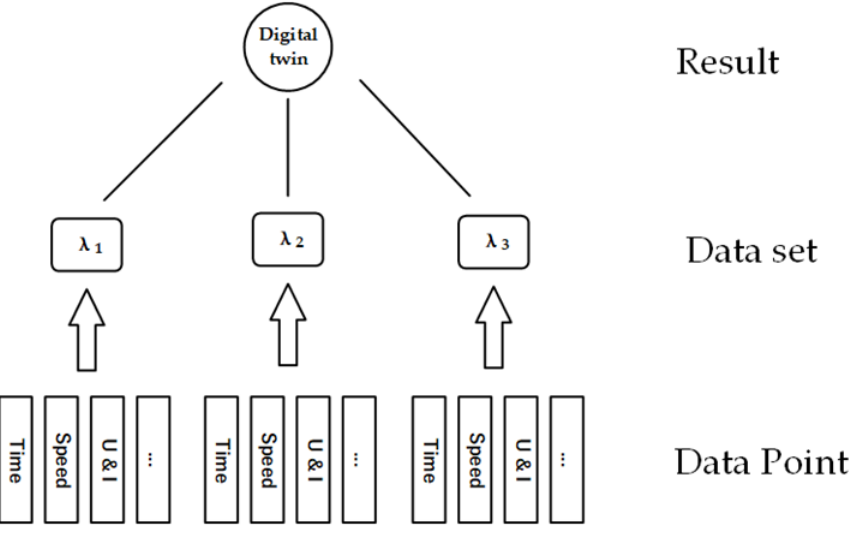
Figure 9. Iterative processing of the data.